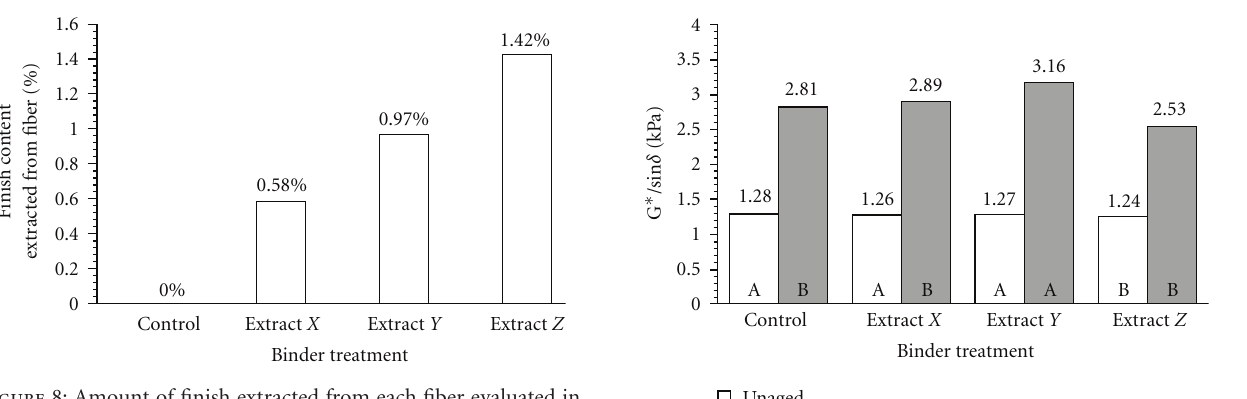
Figure 8: Amount of finish extracted from each fiber evaluated in Phase 2.